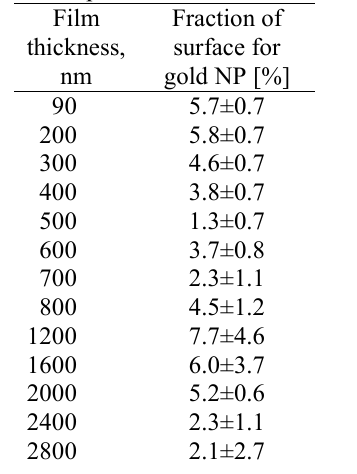
Table 2: Fraction of surface occupied by the